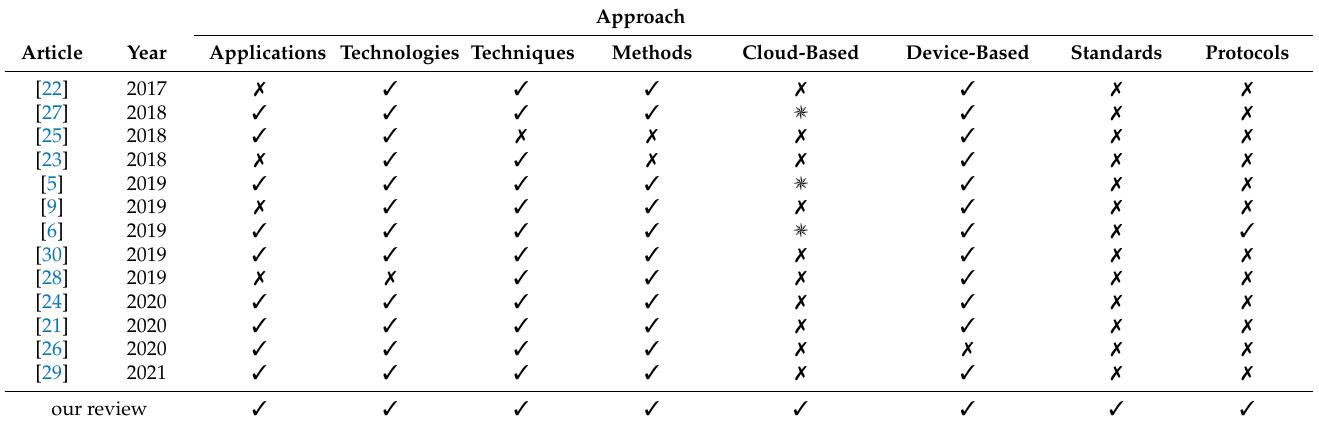
Table 1. Comparison to other reviews and